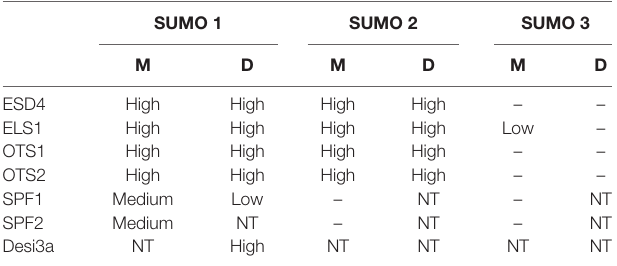
TABLE 2 | Summary of known specificity of SUMO proteases against the different SUMO isoforms in Arabidopsis . SUMO 5 is not included in the